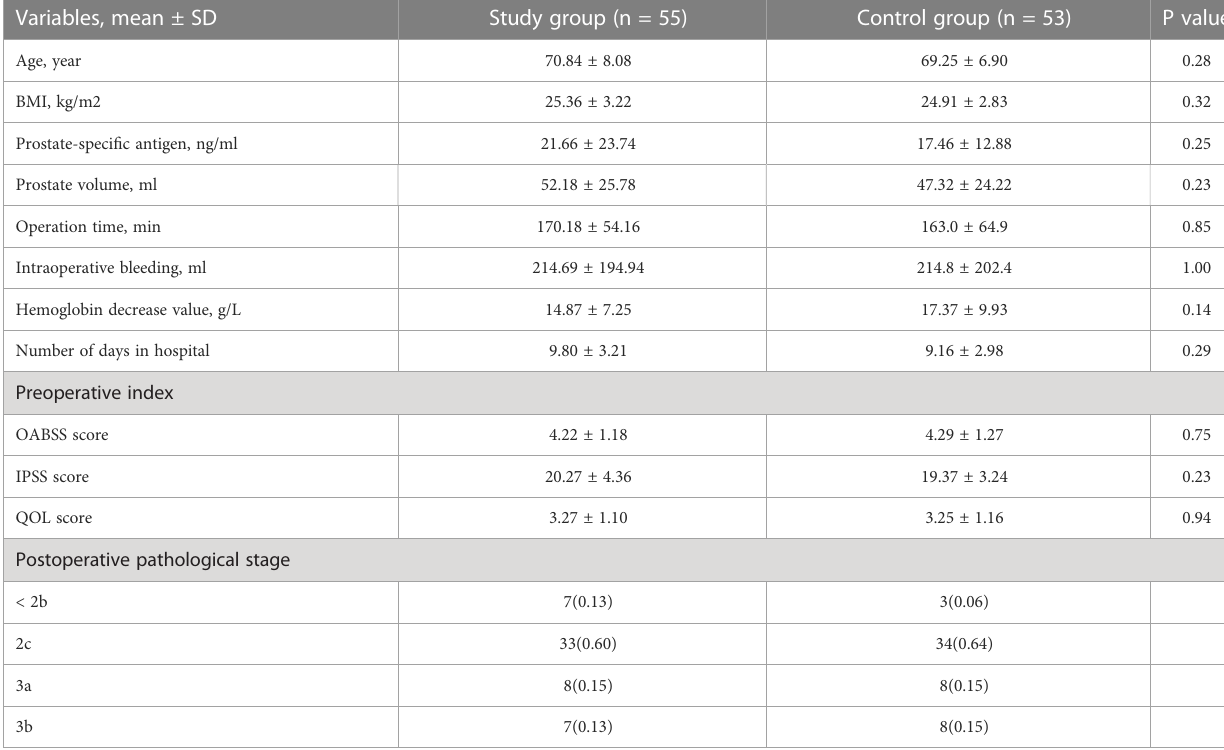
TABLE 1 Population demographics and clinical characteristics of the two groups of patients; preoperative patient OABSS, IPSS, QOL scores and postoperative prostate tumor pathological staging.